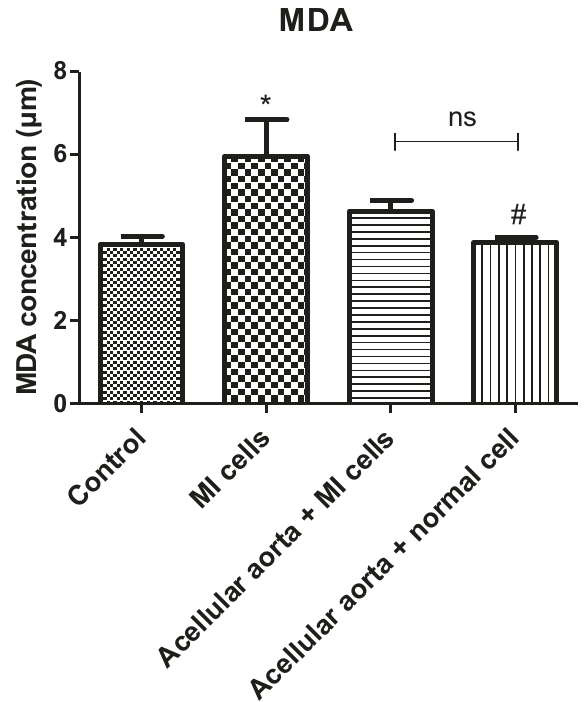
Fig. 5 The measurement of the MDA levels in cardiomyocyte isolated from the MI and healthy heart. The MDA levels were increased in the MI group, while the 3D culture system reduced the concentration of MDA compared to the MI group. *shows the signi fi cant change in comparison to control ( p < 0.05). # shows a signi fi cant change in comparison to the MI group ( p <